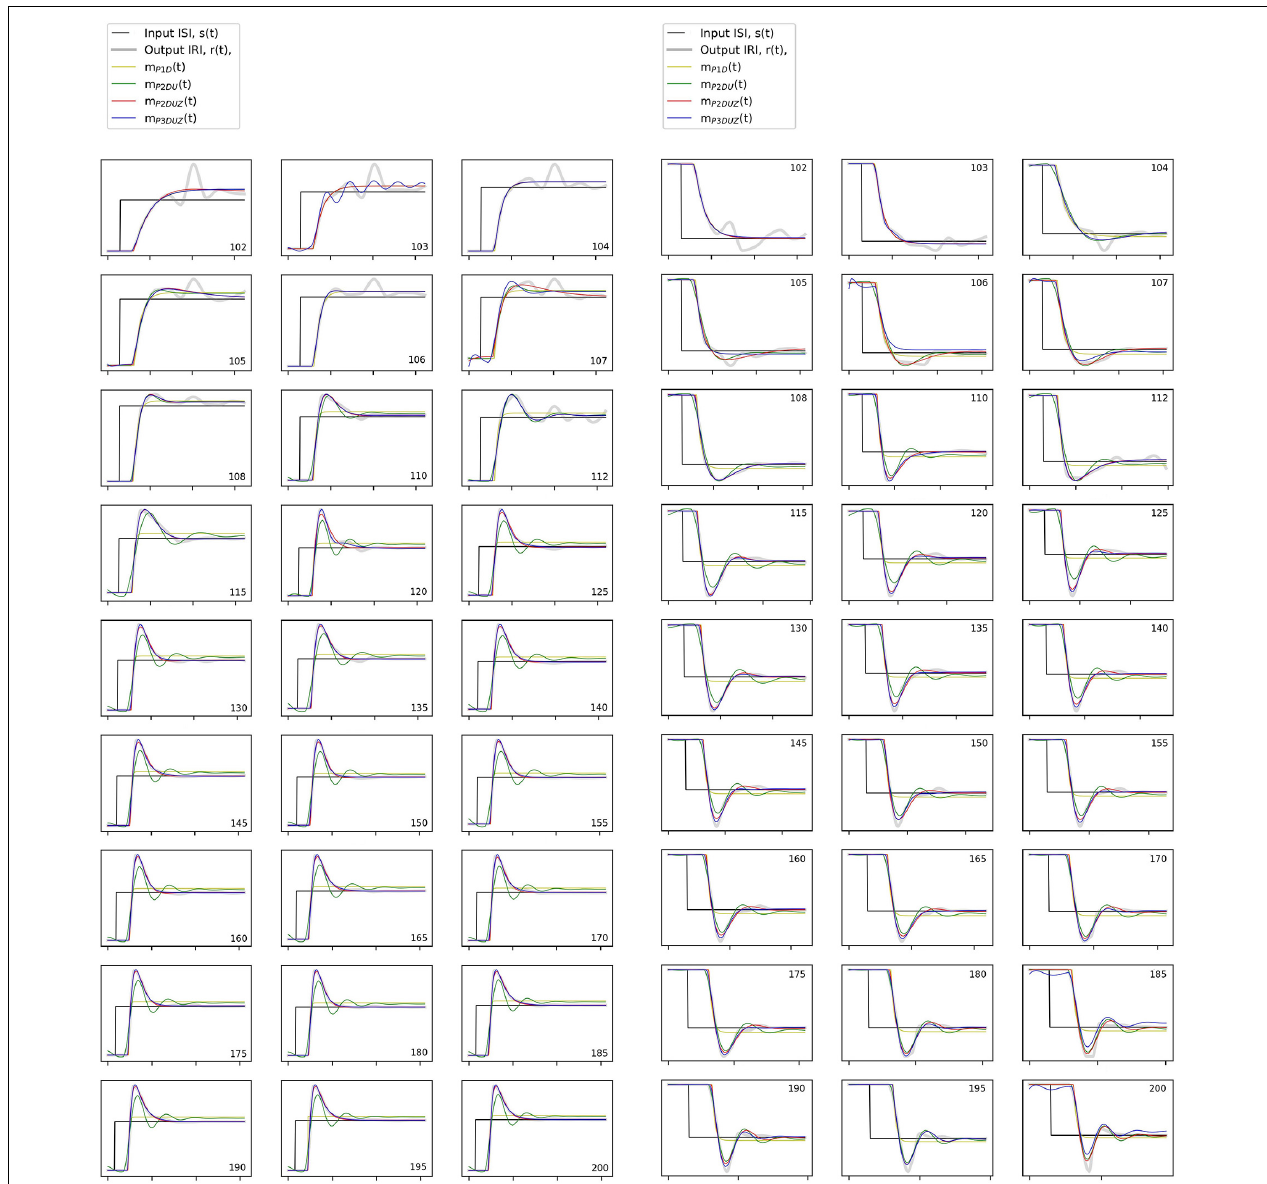
FIGURE 6 | The stimulus signal, s ( t ) (black), observed step response aggregated over participants, r ( t ) (thick gray signal), and modeled response for all models, m P 2 DU ( t ), m P 2 DUZ ( t ), and m P 3 DUZ ( t ) (thin colored curves). The axes are the same as in Figure 4 with a normalized unit step input. The numbers in the corner of the charts represent the initial tempo for the positive steps (left) and the destination tempo for the negative steps (right) in bpm, while the base tempo is 100